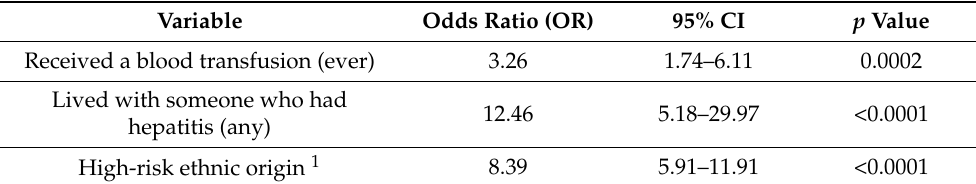
Table 8. Output from the multivariable logistic regression model of case-control interviews, with clinical scenario 2 (likely chronic infection) as the dependent variable